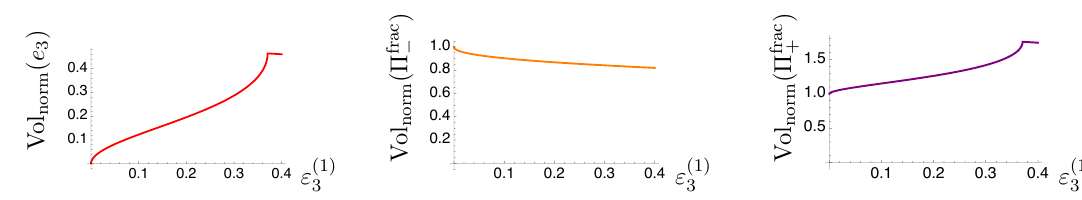
on T 4 = Z 6 and the 3 (1)